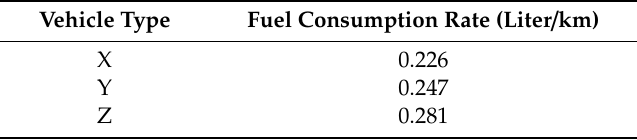
Table 5. The vehicle type and fuel consumption